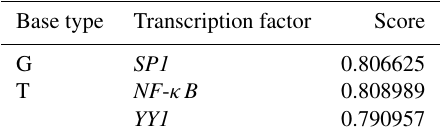
Table 5. Transcription factors of two genotypes on ca. − 379T > G in